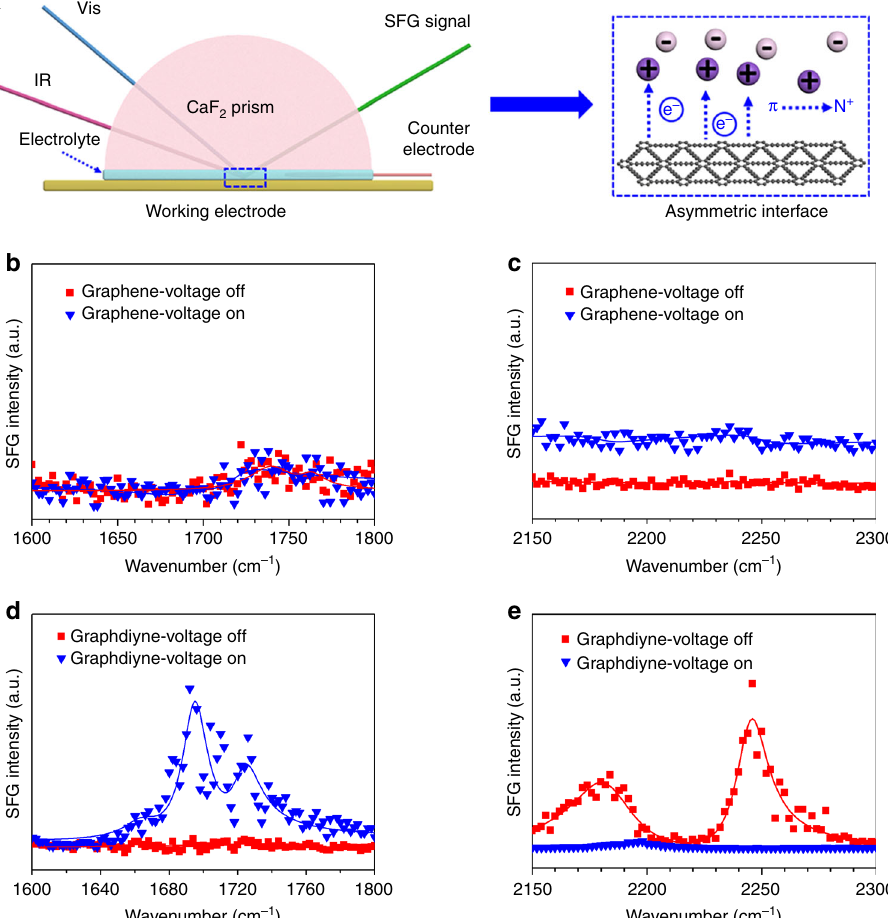
Fig. 5 Veri fi cation of alkene – alkyne complex transition mechanism through the SFG method. a Schematic of the SFG simulative cell. The technique is a second-order nonlinear process with inherent interface selectivity. It involves the overlap of two pulsed laser beams at the asymmetric interface, generating a new beam with a sum frequency of the two. b , c SFG signal of the graphene electrode/EMIBF 4 upon voltage on and off at alkene bond stretching region ( b ) and alkyne bond stretching region ( c ). d , e SFG signal change of the graphdiyne electrode/EMIBF 4 upon voltage on and off in the alkene bond stretching region ( d ) and alkyne bond stretching region ( e